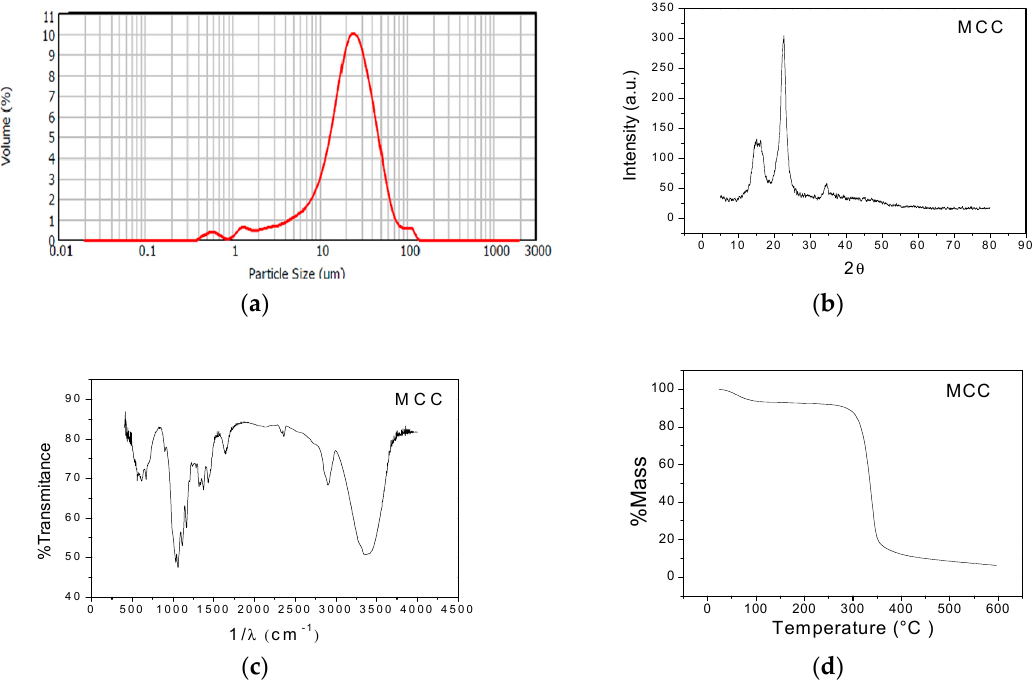
Figure 2. Structural and thermal characterization of MCC. ( a ) Particle size distribution; ( b ) X-ray diffractogram; ( c ) FTIR spectrum; and ( d ) TGA thermogram.